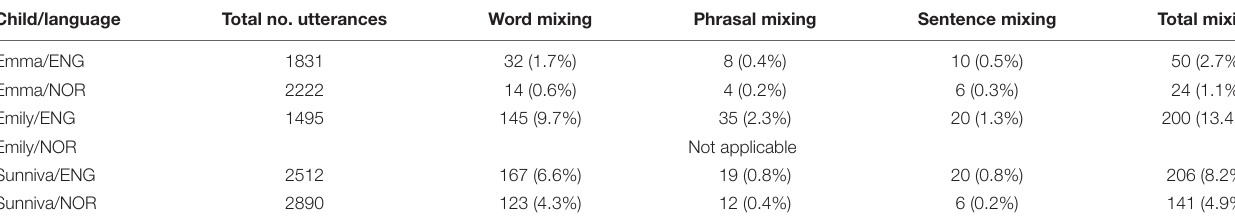
FIGURE 1 | Overview of MLU W in both languages according to age for Emma, Emily and Sunniva. TABLE 10 | Language mixing with words, phrases and sentences in Emma, Emily and